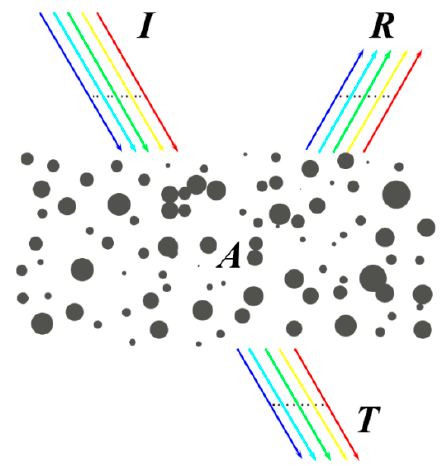
Figure 1. Configuration to simulate the colors of a black carbon (BC) aerosol layer in the atmosphere. “I” represents the incident light. “T” represents the transmitted light. “R” and “A” represent the reflected light and absorbed light, respectively. Randomly distributed spheres represent particles in the aerosol layer.